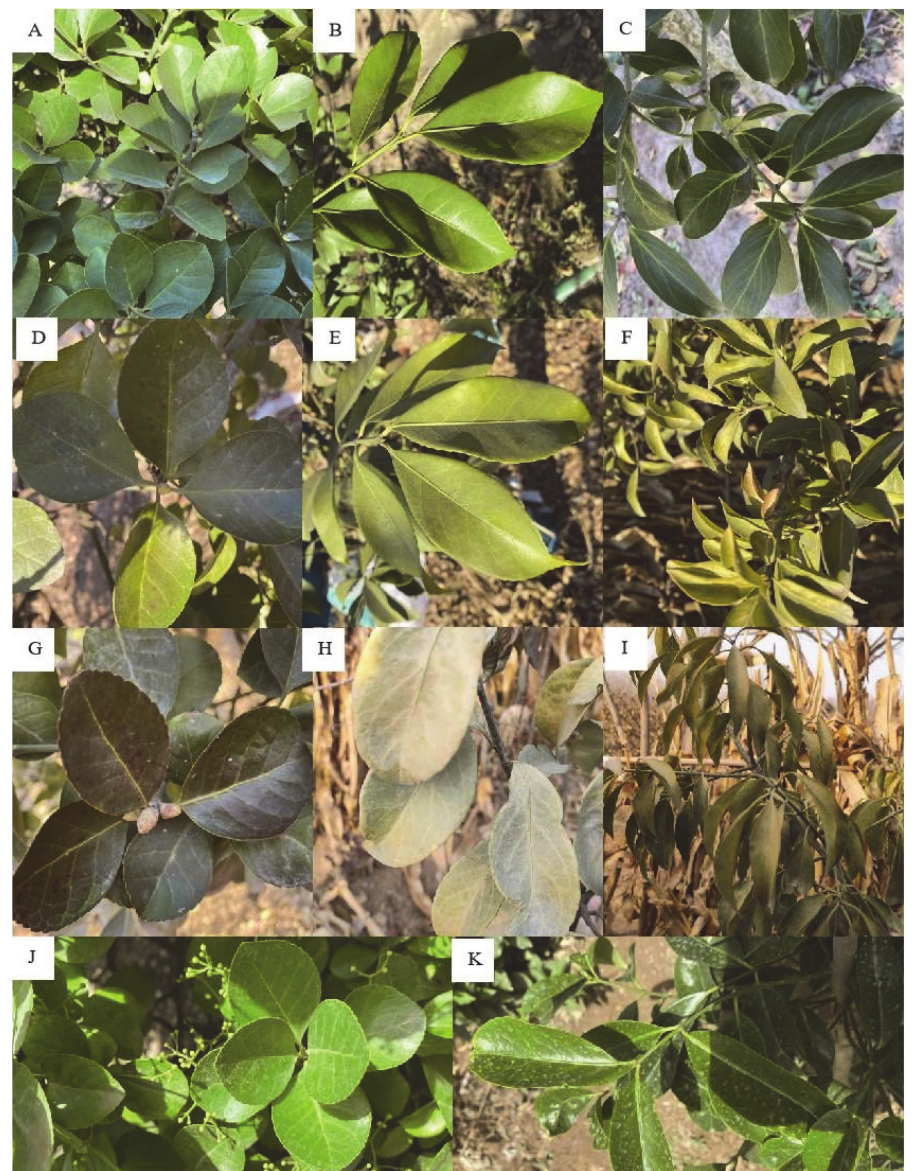
Figure 1. Leaf morphological changes of three species. ( A ) September 2020, E. japonicus